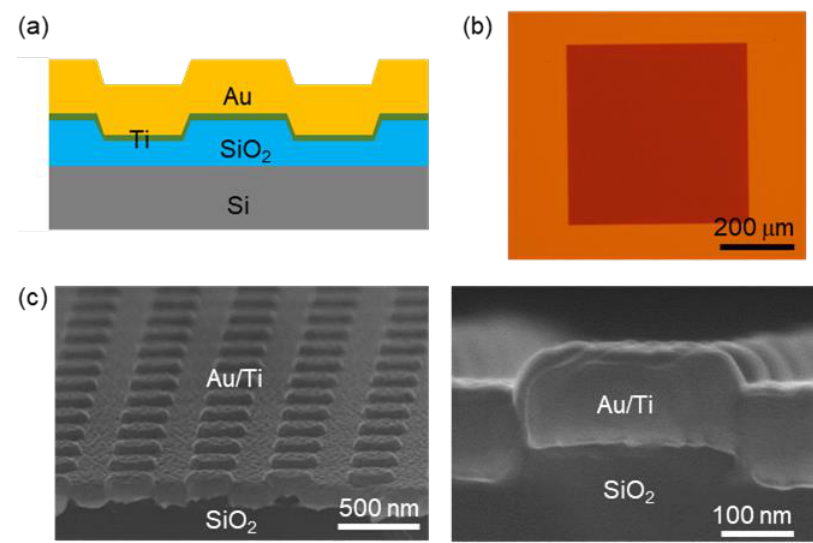
Figure 1. ( a ) Cross-sectional schematic illustration of the Au-NP array. Au (100 nm)/Ti (10 nm) thin films were evaporated on 50-nm-high SiO 2 NP arrays. ( b ) Top-view optical micrograph of the Au-NP pattern (area: 500 × 500 μ m 2 ). ( c ) Scanning electron microscope images of Au-NPs obtained at low (left) and high (right) magnifications.